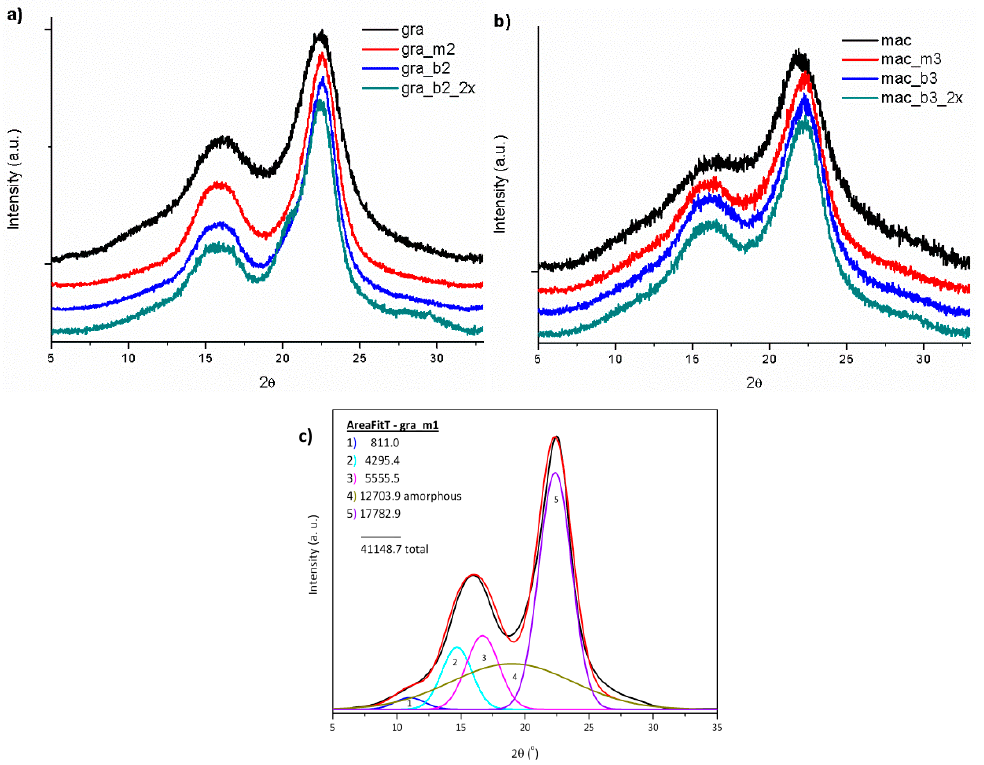
Figure 3. XRD profiles of raw, mercerized and bleached fibers from ( a ) gravata and ( b ) macauba, and ( c ) is an example of deconvoluted peaks for mercerized gravata fibers.